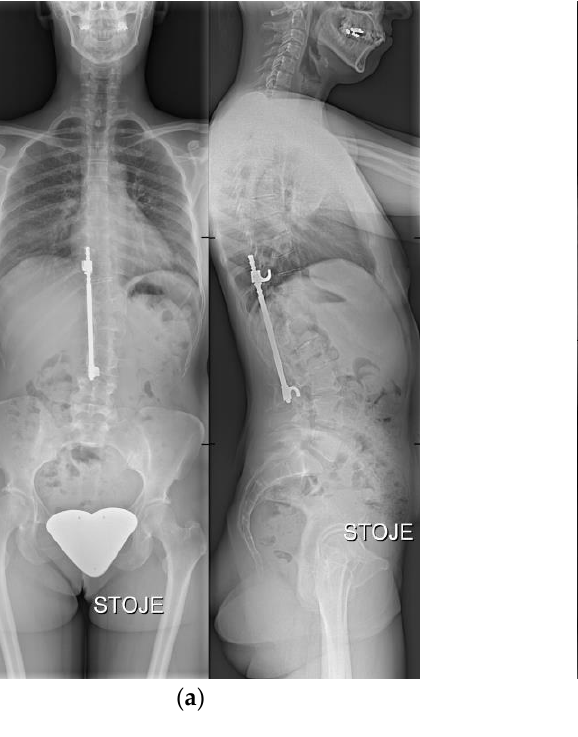
Figure 1. ( a ) X-ray taken before HR instrumentation removal. Anteroposterior ( left ) and lateral ( right ) view. ( b ) Most recent X-ray after HR instrumentation removal. Anteroposterior ( left ) and lateral ( right ) view.